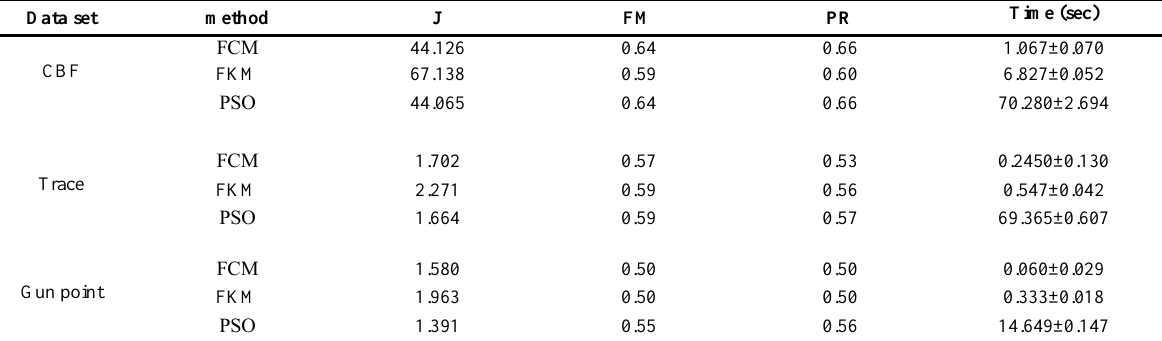
Table 5. Results of three clustering methods on three